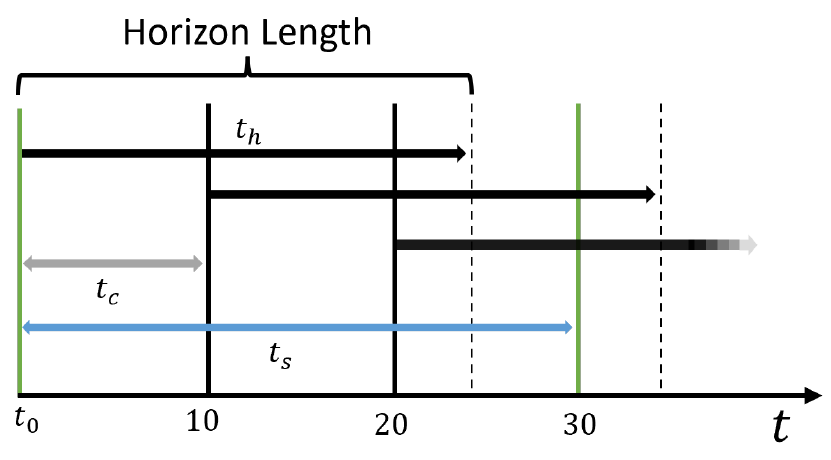
Figure 5. DP-ECMS timing